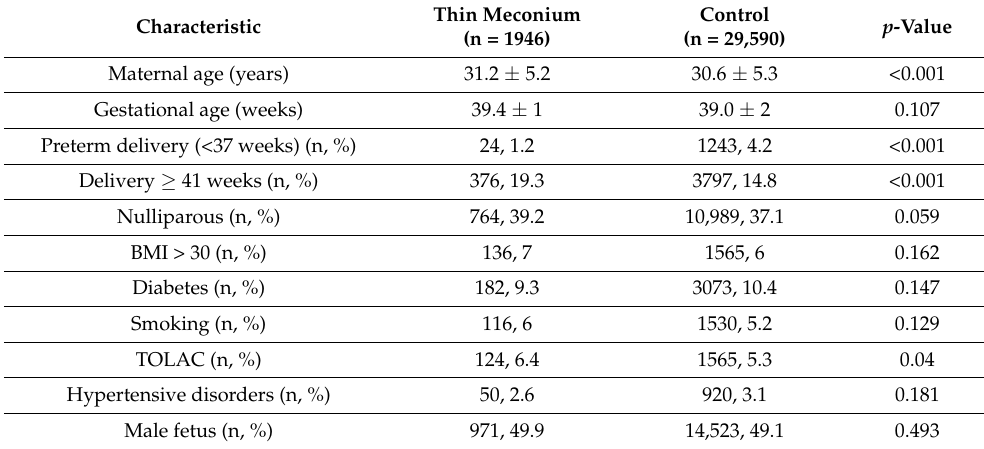
Table 1. Baseline